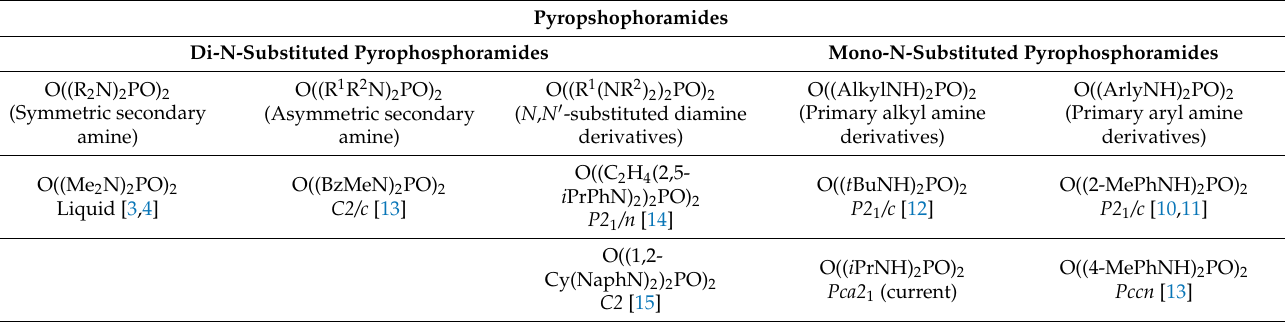
Table 2. Categorisation of pyrophosphoramides discussed in this publication including crystal structures and space groups published from data obtained by single-crystal X-ray diffraction for the solid products, along with the liquid O((Me 2 N) 2 PO) 2 .